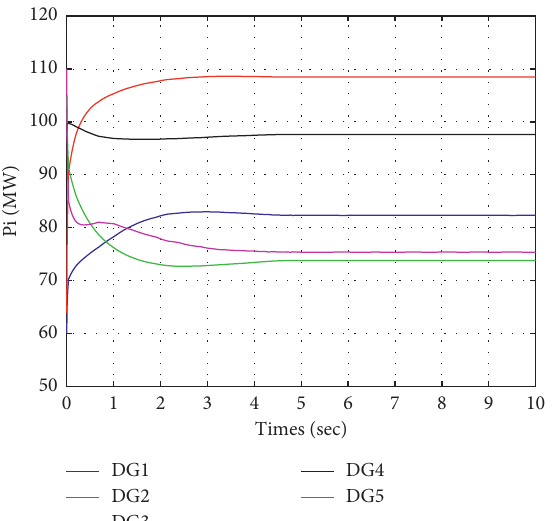
Figure 10: The output power of generator P ation constraints.